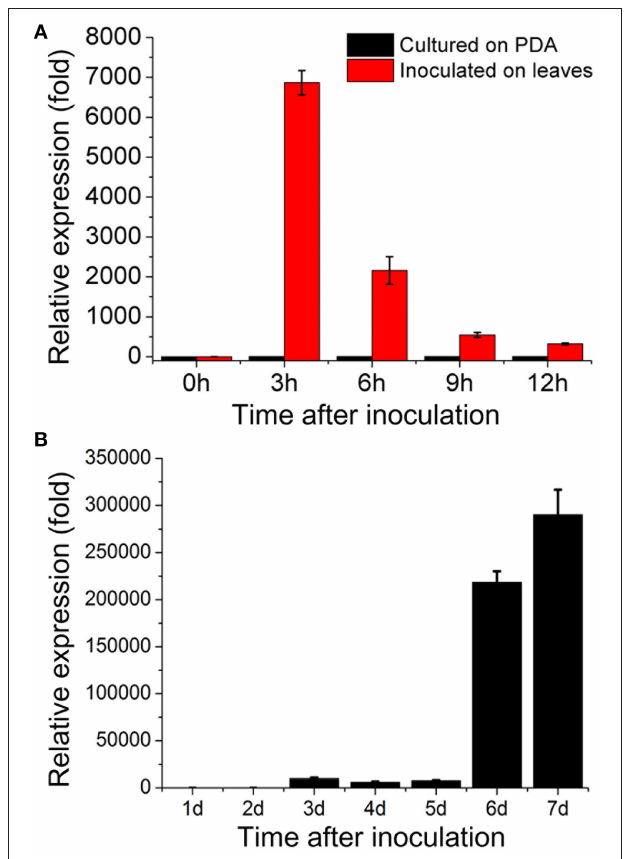
FIGURE 2 | Expression patterns of sop1 . (A) Relative expression of sop1 during infection and vegetative growth as determined by qRT-PCR analysis. The abundance of cDNA from cultures on PDA at 0 hpi was assigned a value of 1. (B) Relative expression of sop1 during sclerotial development as determined by qRT-PCR analysis. The abundance of cDNA from cultures on PDA at 1 dpi was assigned a value of 1. The gene expression levels of sop1 in the wild-type strain were normalized to that of the β -tubulin transcripts from each sample. Bars indicate the standard